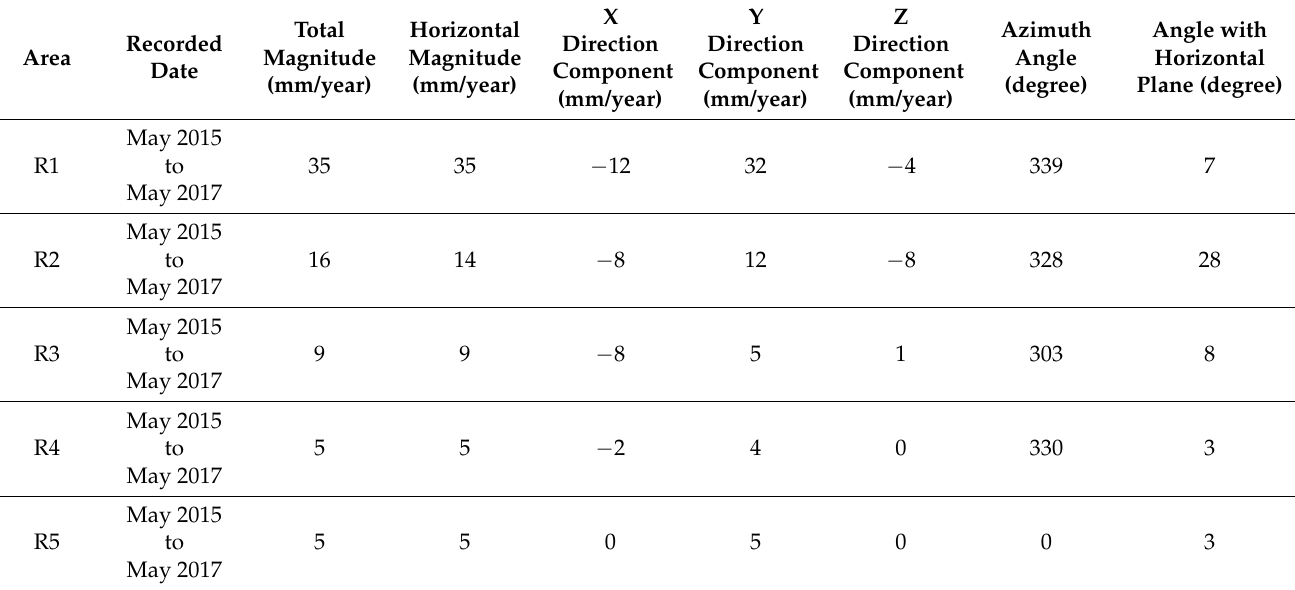
Figure 11. Calculated Vertical component of R for selected sectors of the North landslide. Table 4. Summary of calculated R magnitude and geometry for the North landslide.